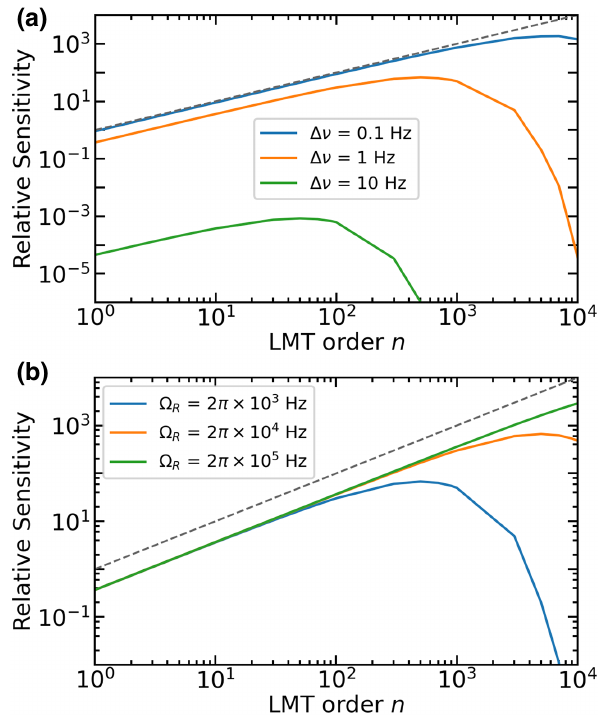
FIG. 3. The relative interferometer sensitivity, defined as nW , as a function of LMT for different values of (a) the laser linewidth / 2 π = 10 3 Hz) and (b) the Rabi frequency (cid:6) (cid:4)ν (with (cid:6) R (cid:4)ν = 1 Hz). The dashed gray lines show linear scaling with LMT and W = 1 for comparison. In all cases, τ = 1 μ s and T 1 = 1